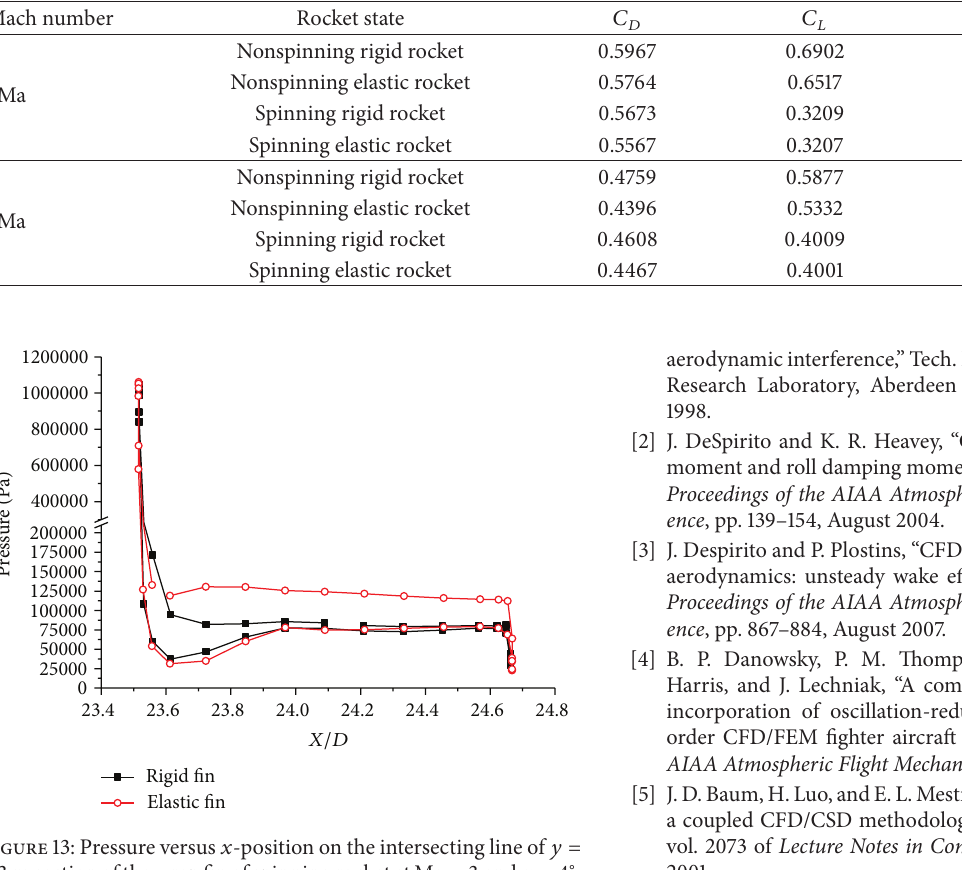
Table 3: Total rocket aerodynamic coefficients.